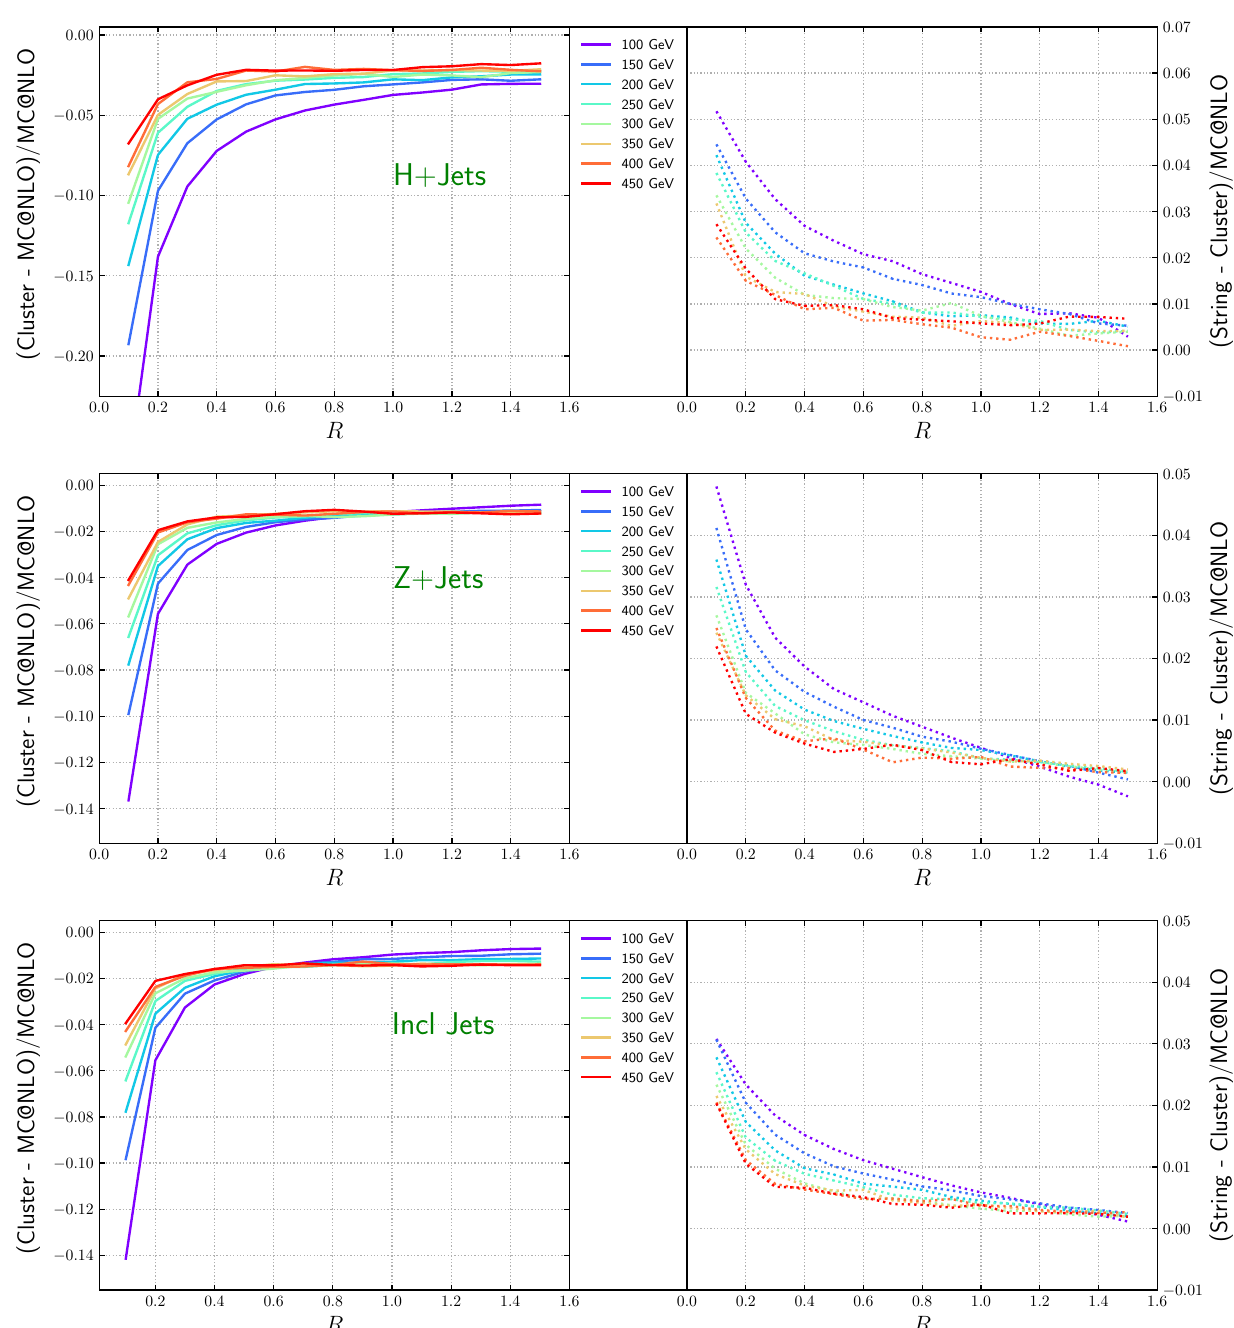
Fig. 19 R-dependence of the hadronization corrections and uncertainties for Higgs + jets (top), Z + jets (middle) and inclusive jets (bottom)